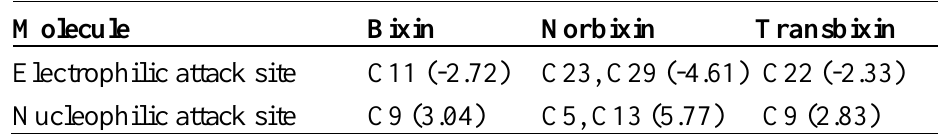
Table 6. Electrophilic and nucleophilic attack sites for bixin, norbixin, and transbixin through Fukui functions and condensed dual descriptors calculated with the M05-2X/6- 31+G(d,p) level of theory and the AOMix program. The value of the condensed dual descriptor (x 100) over the atom is shown in parentheses.